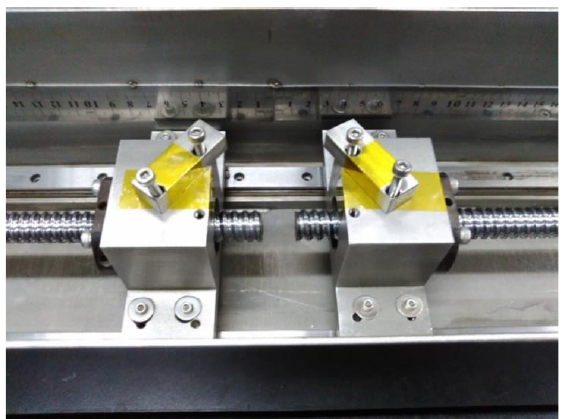
Figure 1. Part of the homemade stretching machine with a water channel.